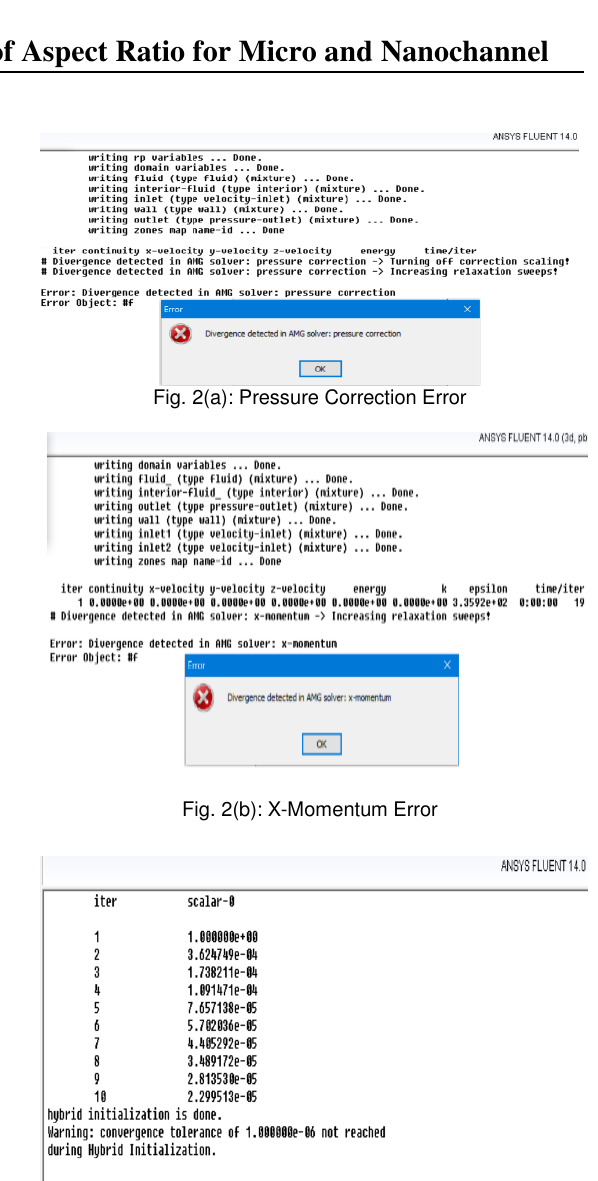
Fig. 2(c): Warning